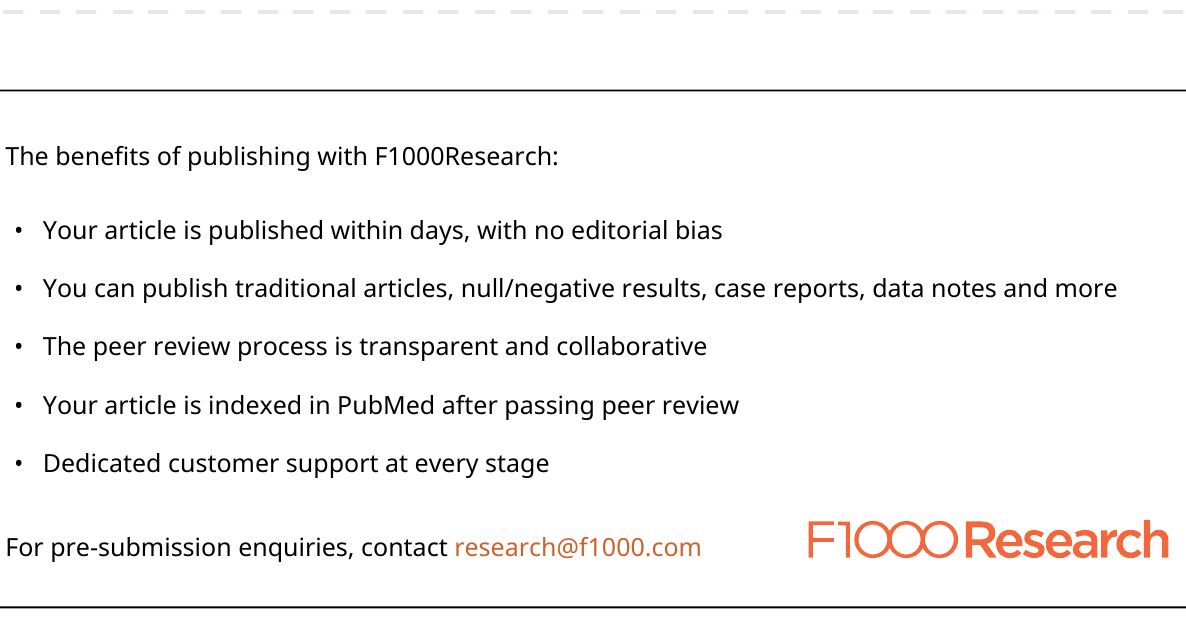
Table 1: change “Calculated Msss” to “Calculated